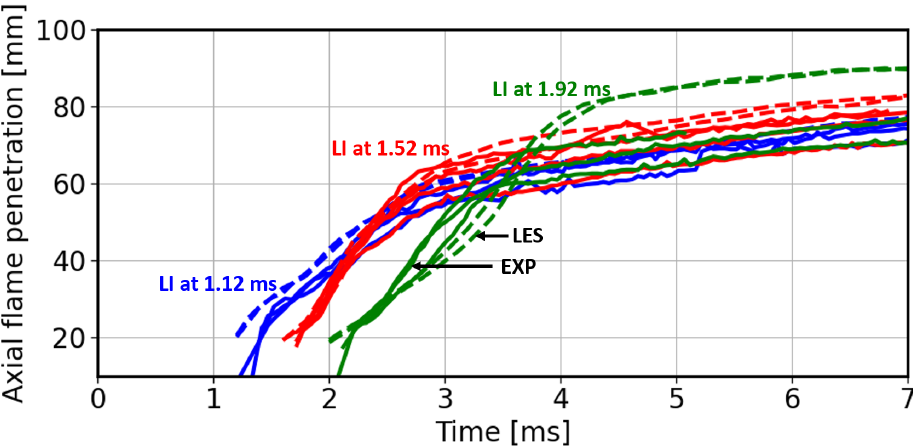
Figure 8. Axial OH* penetration for different laser ignition timings. Multiple realizations are shown for both the experiments (solid lines) and the LES (dashed